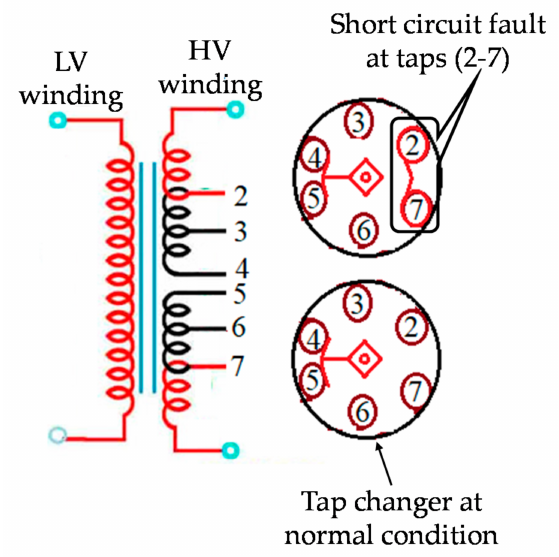
Figure 11. Measurement setup at normal and short circuit fault